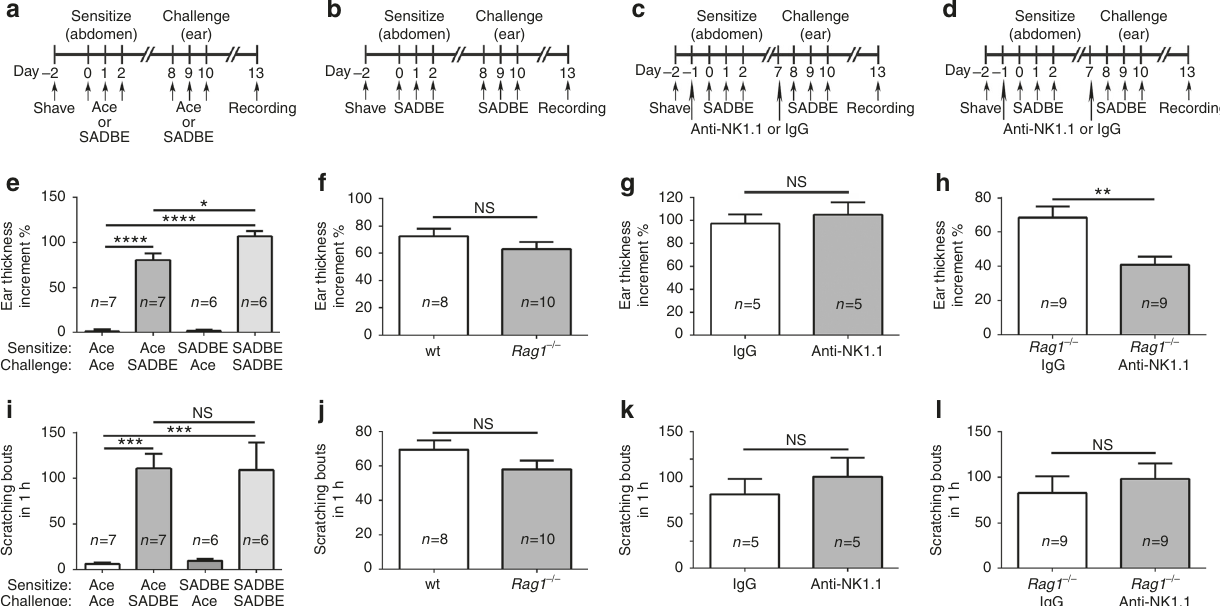
Fig. 1 T lymphocytes contribute partly to skin in fl ammation but not persistent itch. a , e , i Schematic experimental protocol in a was used to test the effect of pretreatment with vehicle (acetone) or SADBE on ear thickness increment ( e ) and spontaneous scratching ( i ) induced by subsequent elicitation of SADBE. Data are presented as mean ± SEM. NS, not signi fi cant. Asterisks indicate statistical signi fi cance. * p < 0.05, *** p < 0.001, **** p < 0.0001, ANOVA; b , f , j Pre-sensitization and subsequent elicitation with SADBE (schematic protocol in b ) induced comparable ear thickness increment ( f ) and spontaneous scratching ( j ) between wt and Rag1 − / − mice. Data are presented as mean ± SEM. NS, not signi fi cant, Student ’ s t -test; c , g , k Pre-sensitization and subsequent elicitation with SADBE (schematic protocol in c ) elicited comparable ear thickness increment ( g ) and spontaneous scratching ( k ) between wt mice treated with either control mouse IgGs or anti-NK1.1. Data are presented as mean ± SEM. NS, not signi fi cant, Student ’ s t -test; d , h , l The Rag1 − / −